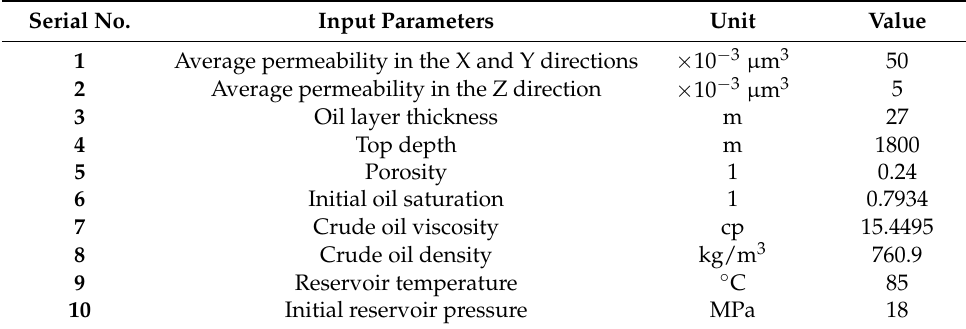
Table 1. Key parameters of the model. Serial